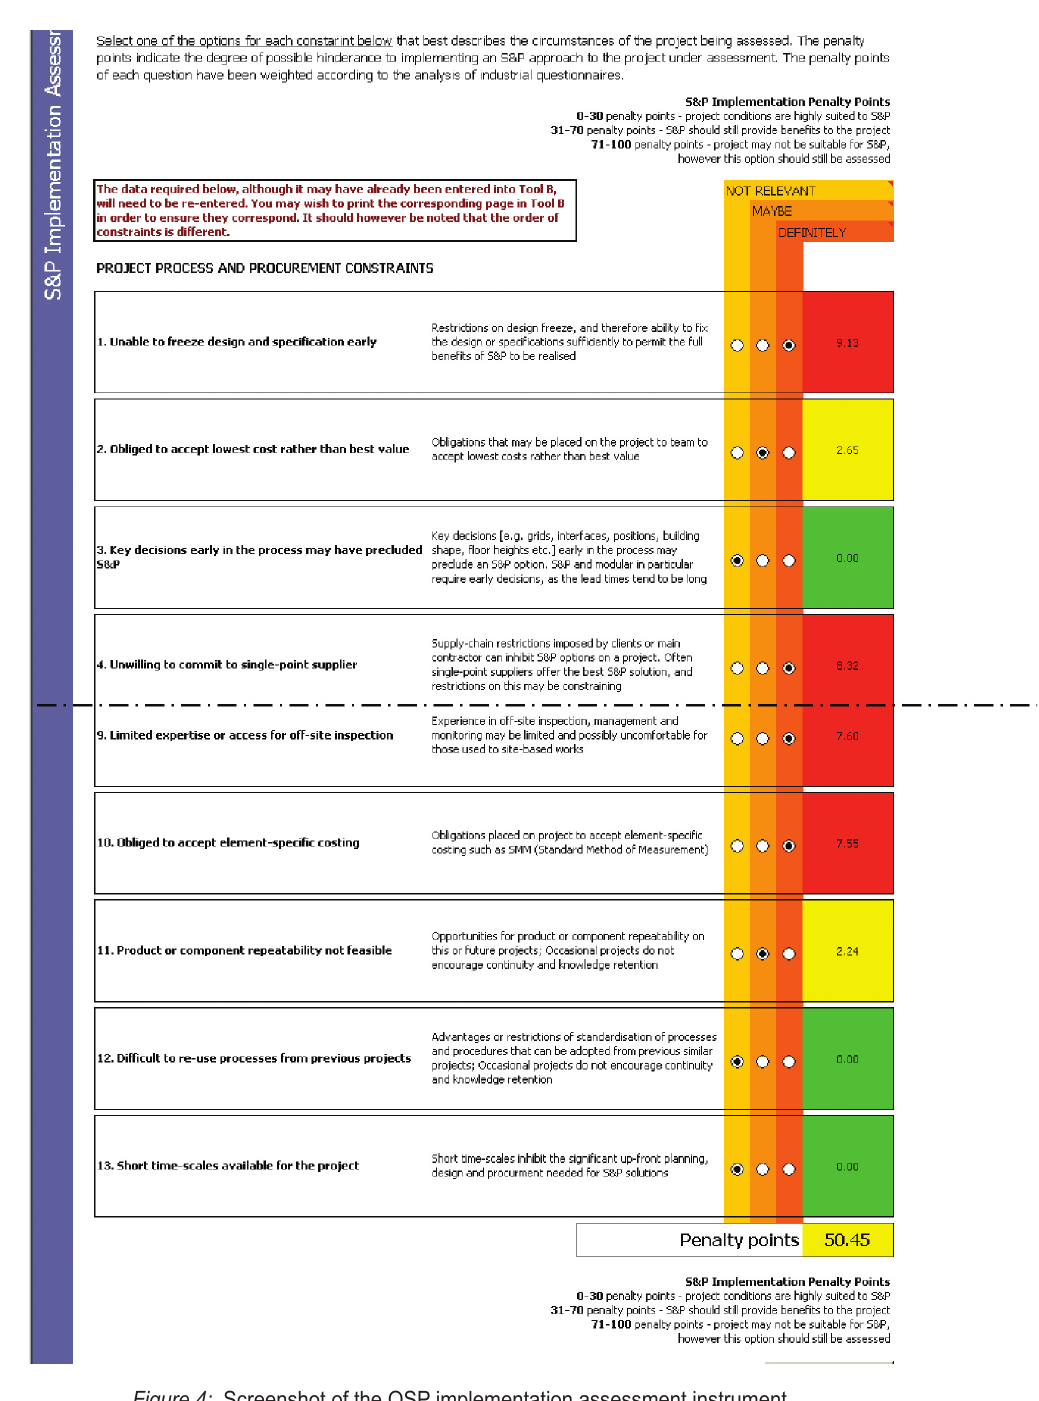
Figure 4: Screenshot of the OSP implementation assessment instrument